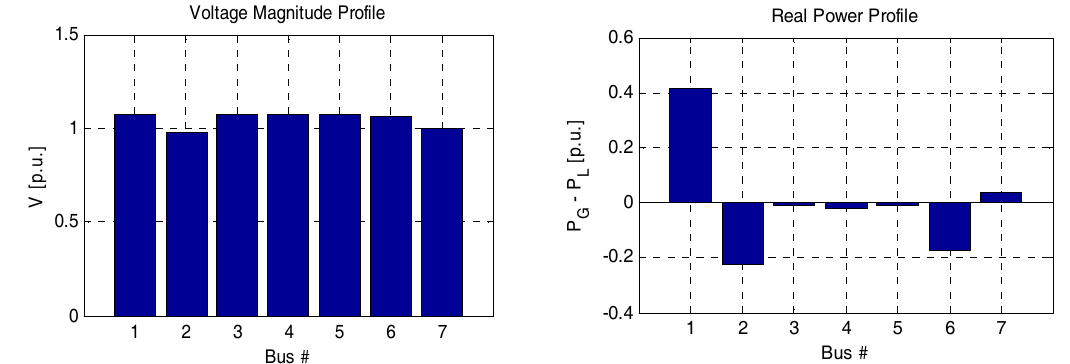
Figure 7. In each bus of the 60-kV electrical grid in Tiaret region: ( a ) voltage amplitudes; ( b ) active powers.